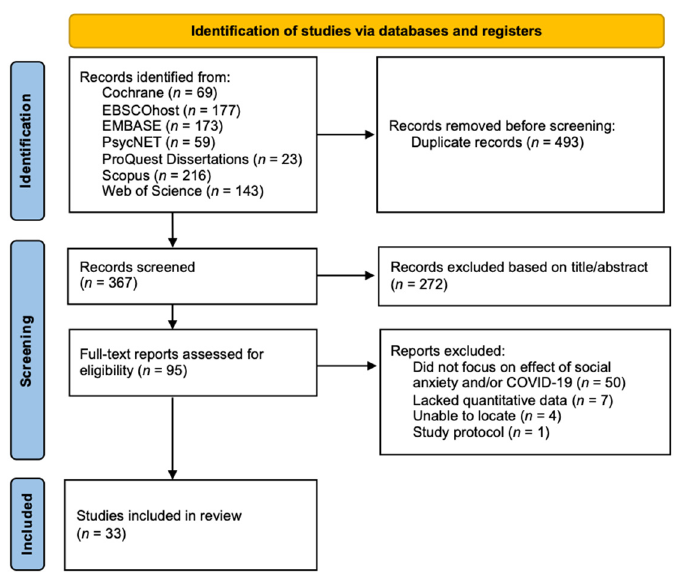
Figure 1. PRISMA Flow-chart for the Selection of Eligible Studies.